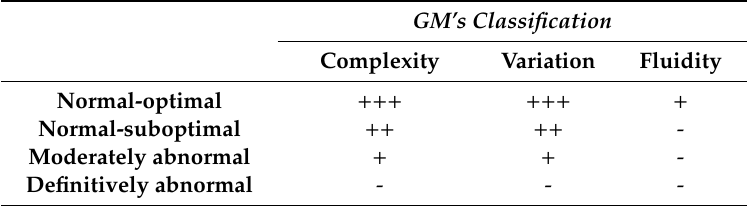
Table 1. Classification of quality of general movements (GM’s)